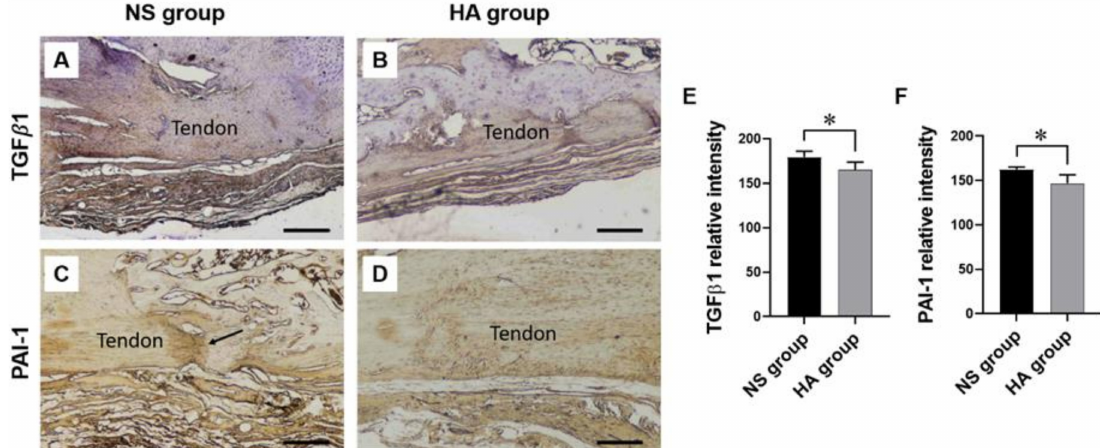
Figure 3. Representative images of transforming growth factor- β 1 (TGF- β 1) and plasminogen activator inhibitor (PAI-1) immunohistochemical staining and analyses at 10 weeks after surgery. ( A ) TGF- β 1 staining in the NS group: dense and irregular collagen fibers are observed between the repaired tendon and the surrounding soft tissue. The collagen fibers forming adhesions and connecting soft tissue to the tendon surface are observed. Scale bar = 100 µ m. ( B ) TGF- β 1 staining in the HA (experimental) group: a few loose collagen fibers are observed between the repaired tendon and the surrounding tissue. The adhesion fibers have a more regular pattern in the HA group than in the NS group. Scale bar = 100 µ m. ( C ) PAI-1 staining in NS group: high expression is observed in the repaired tendon (arrow), and the surrounding adhesion tissue consists of collagen fibers and extracellular matrix. Scale bar = 100 µ m. ( D ) PAI-1 staining in the HA group: significantly lower PAI-1 expression is observed in the HA group than in the NS group. Scale bar = 100 µ m. ( E , F ) Staining results are quantified using ImageJ. The y-axis indicates the mean intensity of staining. Significantly lower ( E ) TGF- β 1 and ( F ) PAI-1 expression is observed in the HA group than in the NS group (* p < 0.05). Values represent the means ± standard error of the mean (SEM). ( n = 12 for each